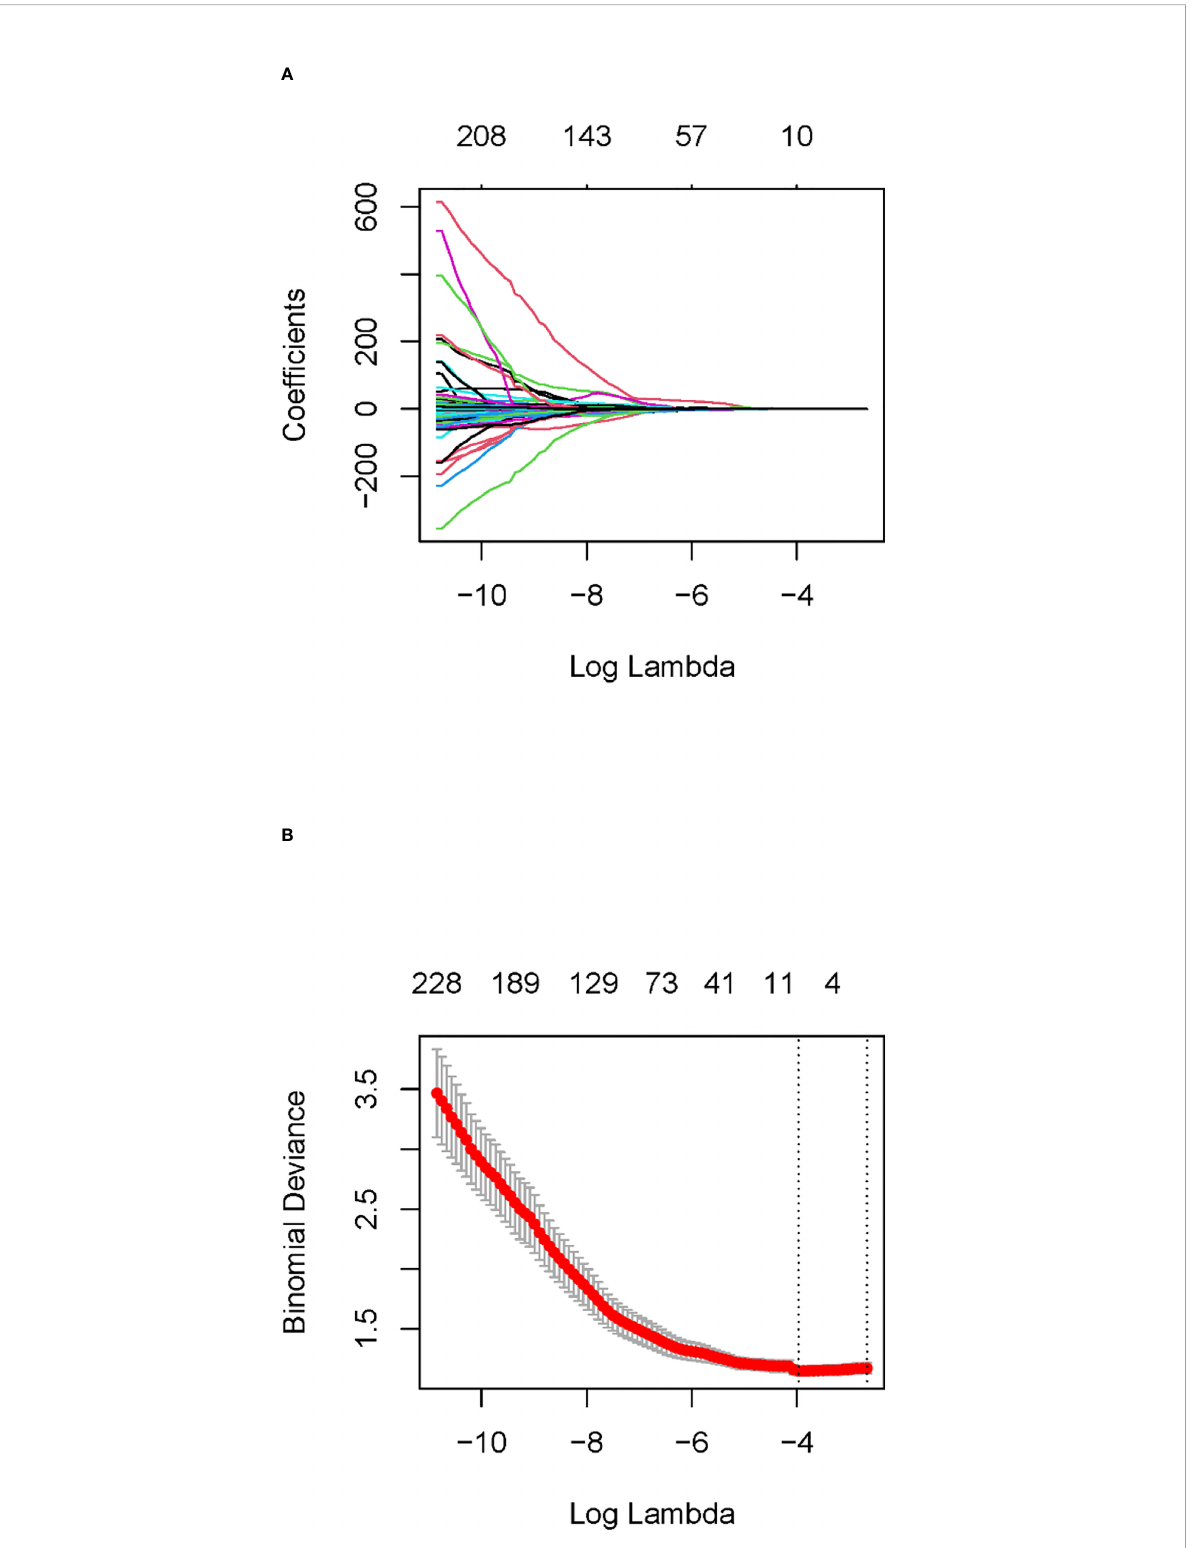
FIGURE 4 Least absolute shrinkage and selection operator (LASSO) coef fi cient pro fi les (A) and determining the parameter Lambda ( l ) in the LASSO model with 10-fold cross-validation (B)